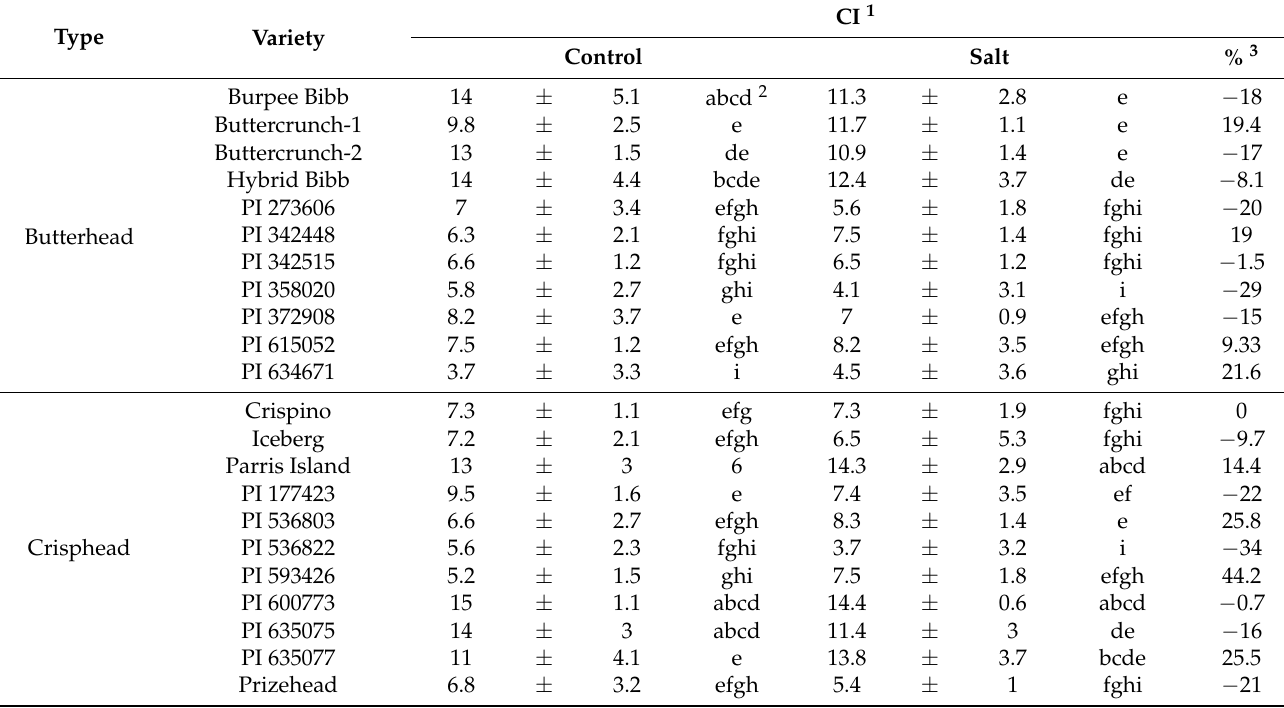
Table 7. Chlorophyll index (CI) (mean ± standard deviation, n = 6) of butterhead- and crisphead-type lettuce cultivars grown under control and salt-stress conditions (100 mM) after 42 days of sowing (10 days after salt treatment). Type